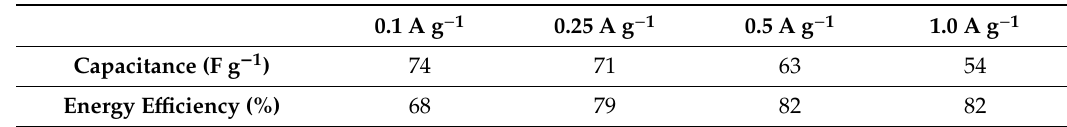
Table 2. Capacitance and energy efficiency values calculated from galvanostatic charge/discharge curves at each specific current for hybrid cell 1.